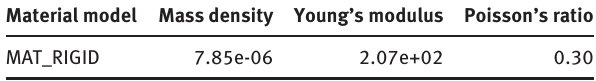
Table 1 Material properties of impacting mass.